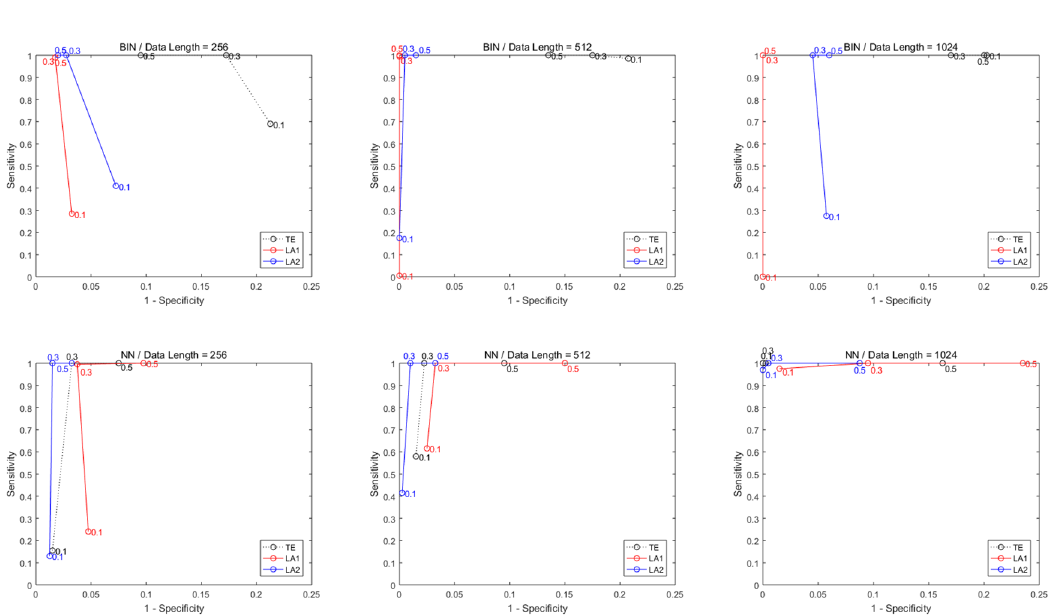
Fig 12. ROC curves for Model F with different data lengths and coupling strengths. Sensitivity and specificity are obtained from three coupled Henon maps with data length from 256 to 1024 and coupling strength (marked in the figure) from 0.1 to 0.5. The first row shows results from the methods applying binning estimator and second row for NN estimator. Column 1 to 3 is with data length from 256 to 1024. Each simulation was performed by 100 runs.